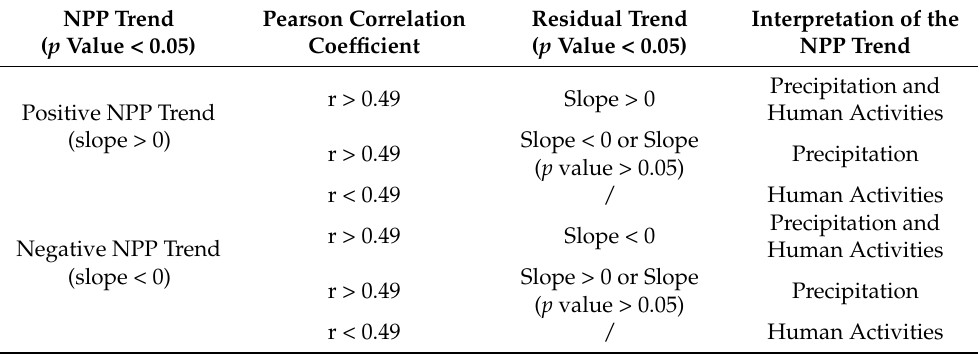
Interpretation of the